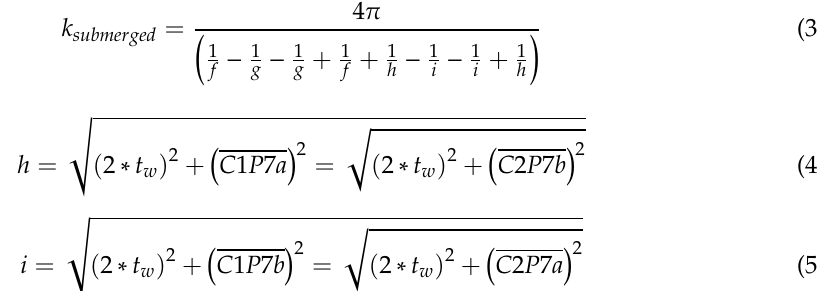
E ff ective water-level variations: There are two e ff ects, which we combine into an “e ff ective water-level variation”. The first one is swell, which displaces the electrodes in the vertical direction, thus changing their distance to the sea bottom. It depends on the speed, lengths and heights of the water waves. The second e ff ect is the possible variation of bathymetry in the cross-line direction, which a ff ects the measurements through the varying cross-line deflections of the streamer. Quantifying these e ff ects in an exact way would require, besides bathymetry, accurate knowledge of the 3D positions. As this is hardly achievable, we attempt to estimate the order of magnitude of the resulting uncertainties by assuming that they can be modelled by the temporal variation of an “e ff ective water-level”. For this purpose, we compute the apparent resistivity values for a set of two-layer (2L) models. The thickness of the upper layer, identified with the water column of 0.3 Ω m resistivity, is varied between 0.8 and 1.2 m in intervals of 10 cm. At an average water depth of 1 m, the curves correspond to an e ff ective water-level variation of ± 10 and ± 20 cm. For the bottom layer, resistivity values of 1 and 100 Ω m were chosen. A bottom resistivity of 1 Ω m corresponds to saturated sand or clay, whereas a bottom resistivity of 100 Ω m corresponds to saturated limestone [14]. In order to estimate the measurement uncertainty for the di ff erent setups, an e ff ective water-level variation of 5 cm was assumed for setup S, of 10 cm for setup F and of 20 cm for setup T. The uncertainty is defined to be the di ff erence between apparent resistivity of the average water depth and of the maximum water displacement. Repeatability of profile locations: To complete the considerations on the errors of the three measurement setups (F, S, T), the general positioning uncertainty of the mid streamer point was evaluated in inline and cross-line directions using the data of setup T, which is assumed to have the largest uncertainties in positioning. This was estimated using the deviations of the GNSS (global navigation satellite systems) coordinates from the mean profile track, the possible streamer deflections and the inline “smearing interval length” of data due to the streamer movements during a measurement cycle for setup T. The positioning uncertainty provides e ff ective water-level variations in a sloped seafloor, similar to cable deflections, and thus uncertainties in apparent resistivity. They have been summarized above in point (d). In addition, the positioning uncertainty restricts the prospection of laterally limited